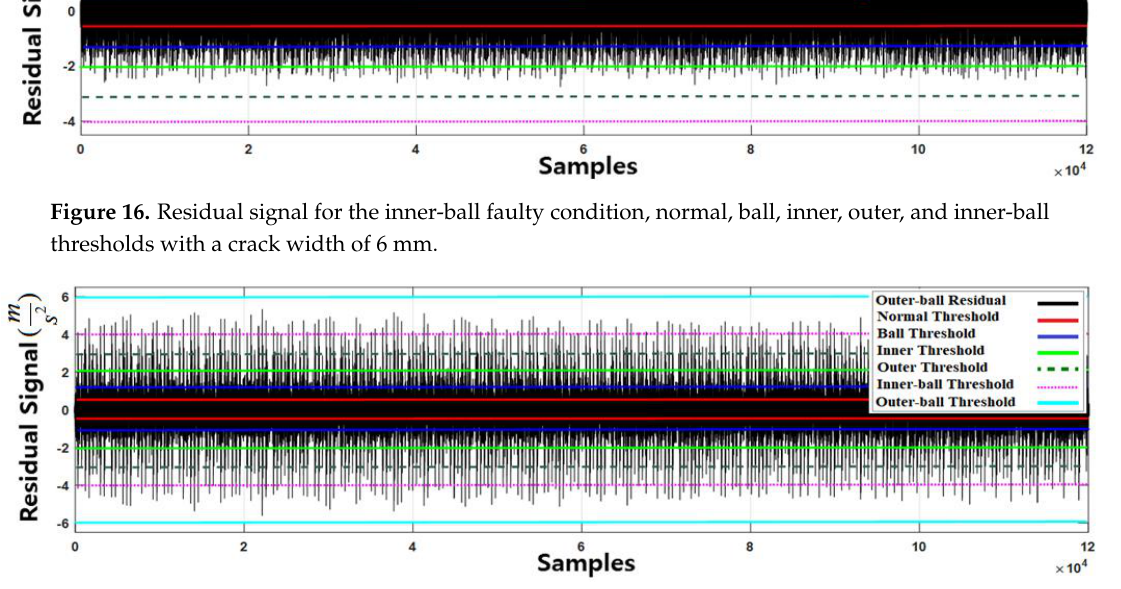
Figure 17. Residual signal for the outer-ball faulty condition, normal, ball, inner, outer, inner-ball, and outer-ball thresholds with a crack width of 6 mm.